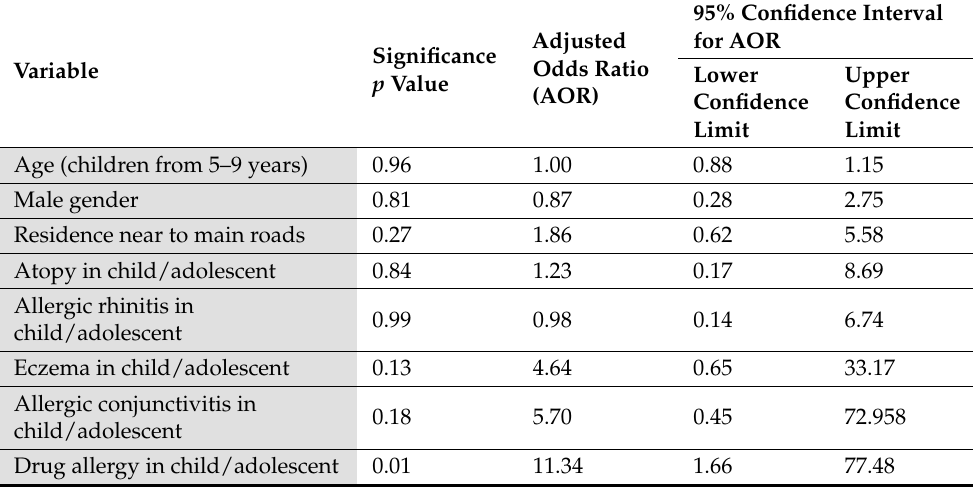
Table 4. Multivariate regression analysis for risk factors of wheezing in the last 12 months in children and adolescents in Rabigh